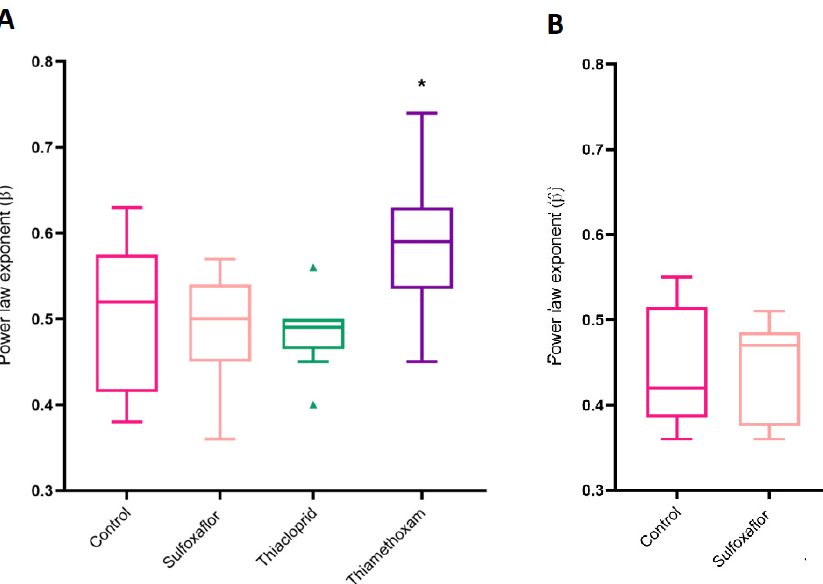
Figure 10. ( A ) β -exponent of bees in the lower concentration insecticide experiments post-training. Mean speed–curvature power law exponents for control 0.51 (range = 0.39:0.63), sulfoxaflor, 0.49 (range = 0.36:0.57), thiacloprid 0.49 (range = 0.4:0.56) and thiamethoxam 0.59 * (range = 0.45:0.74). Control n = 9, sulfoxaflor n = 9, thiacloprid n = 9 and thiamethoxam n = 9. Coloured triangles ( (cid:78) ) represent individual bee outlier data. ( B ) β -exponent of bees in the higher concentration insecticide experiments post-training. Mean speed–curvature power law exponents for control = 0.44 (range 0.36:0.55), sulfoxaflor = 0.44 (range 0.36:0.51). Control n = 9, sulfoxaflor n = 9.